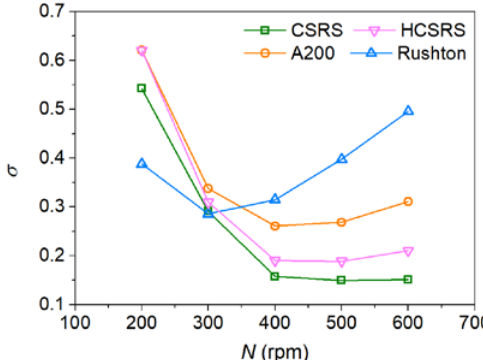
Figure 14. Effect of stirring speed on the relative standard deviation of particle concentration for the four types of agitators.